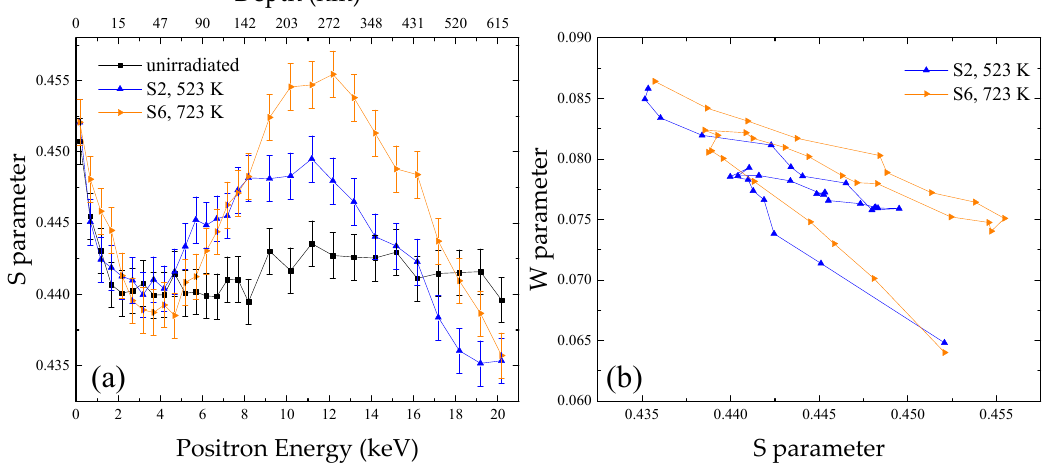
Figure 6. ( a ) S–E curves and ( b ) S–W curves for RAFM steels irradiated to the fluence of 1 × 10 20 m − 2 at different temperatures (523 and 723 K).